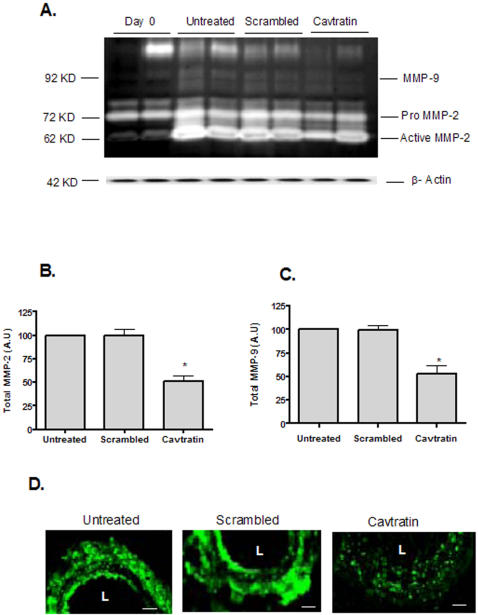
Cavtratin and Gelatinase Activity in Porcine Arterial rings.A- Representative zymogram of tissue homogenates from porcine arterial rings at baseline (0 days) and after 3 days in culture in the presence and/or absence of scrambled and Cavtratin peptides (10 µµ). Data represent 5 independent arterial rings., A representative western blot showing β-actin expression, demonstrating equal protein loading (bottom panel). B- Quantification of total MMP-2 (Pro and active MMP-2) in porcine arterial rings after 3 days in culture in the presence and/or absence of Cavtratin and scrambled (10 µµ). Data represent 5 different arterial rings. * p = 0.02 compared to untreated rings. C- Quantification of total MMP-9 in porcine arteries after 3 days in culture in the presence or absence of Cavtratin and scrambled (10 µM). Data represent 5 different arterial rings. * p = 0.01 compared to untreated rings. D- In situ zymography obtained from cutured rings. Gelatinolytic activity is shown in green. Scale bar = 100 µm. L = Lumen.